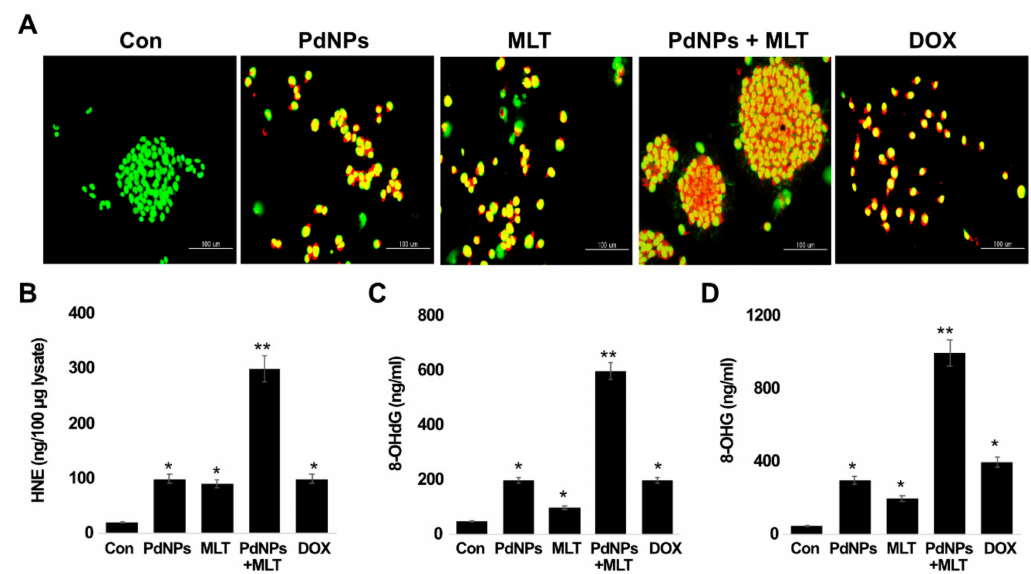
Figure 9. PdNPs + MLT induce apoptosis and oxidative DNA damage. ( A ) Morphological observation of cells under each treatment. Green staining indicated viable cells, whereas yellow-stained cells were early apoptotic and reddish- or orange-stained cells were late apoptotic. Each experiment was performed in triplicate ( n = 3) and similar morphologic features were observed. Original magnification 200 µ m. Levels of ( B ) HNE, ( C ) 8-Oxo-dG, and ( D ) 8-Oxo-G level. Results are shown as the mean ± standard deviation of three independent experiments. Student’s t- test revealed a significant di ff erence between treated and untreated cells (* p < 0.05) and between the treated and control cells. * p < 0.05 was considered significant; ** p < 0.01 was considered highly